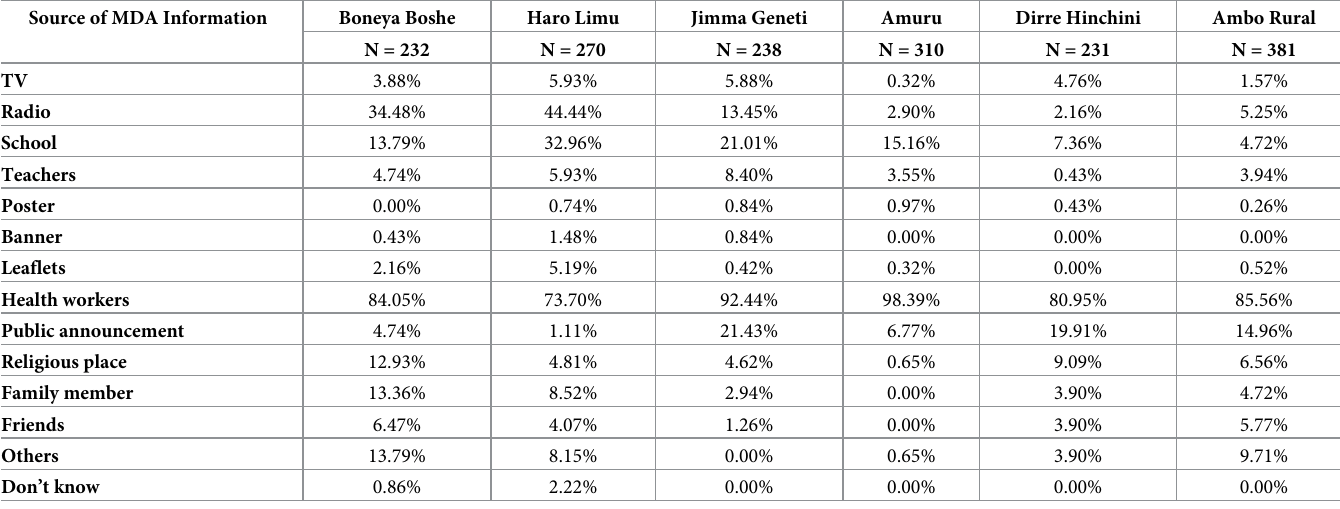
Table 5. Source of information about Trachoma MDA campaign in six districts of East Wollega, Horo Guduru and West Shewa zones of Oromia,